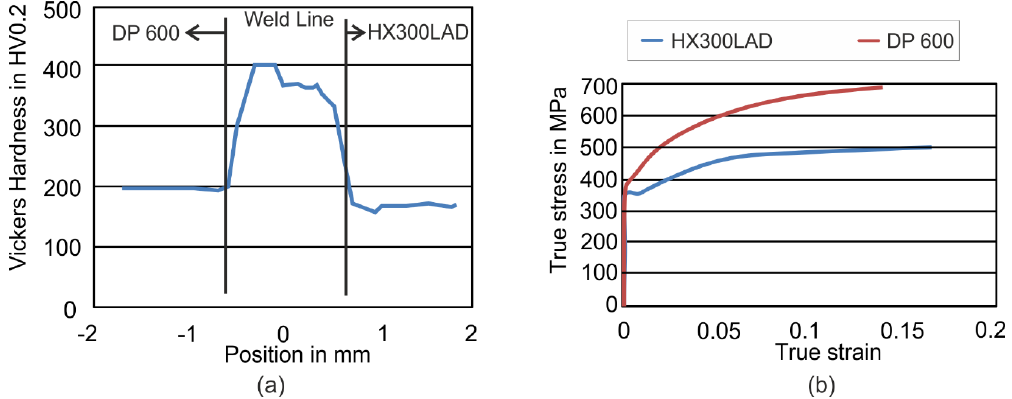
Figure 1. ( a ) Hardness distribution across the weld line for Tailor Welded Blank; ( b ) flow curves of DP600 and HX300LAD steels. DP600 and HX300LAD steels.